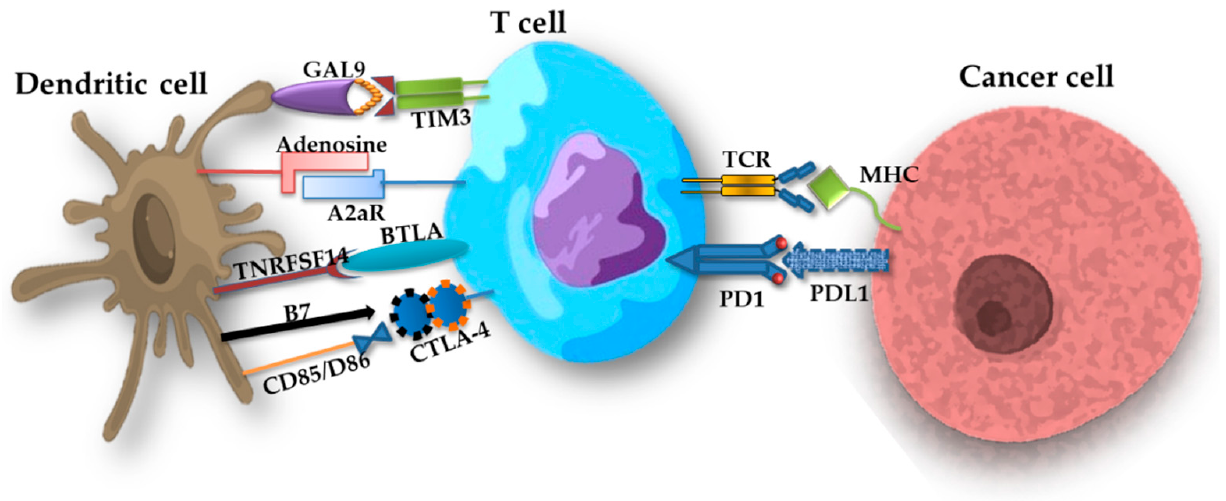
Figure 5. Exemplary interactions between a T lymphocyte and a tumor cell and dendritic cell, including immunological checkpoints (based on [350–355]).